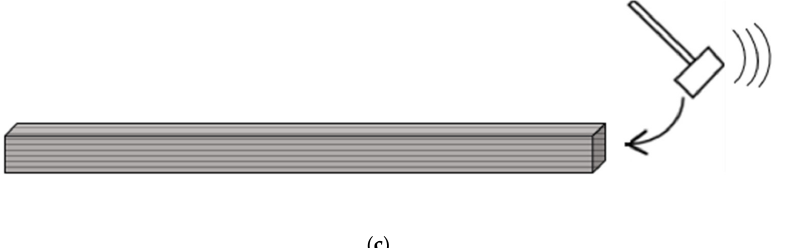
Figure 6. Schematic of measurement methods for predicting MOE of the boards. ( a ) Edge-wise four-point bending using Calibre STFE10 Machine, ( b ) Flat-wise three-point bending using MSG, ( c ) Longitudinal acoustic wave velocity.